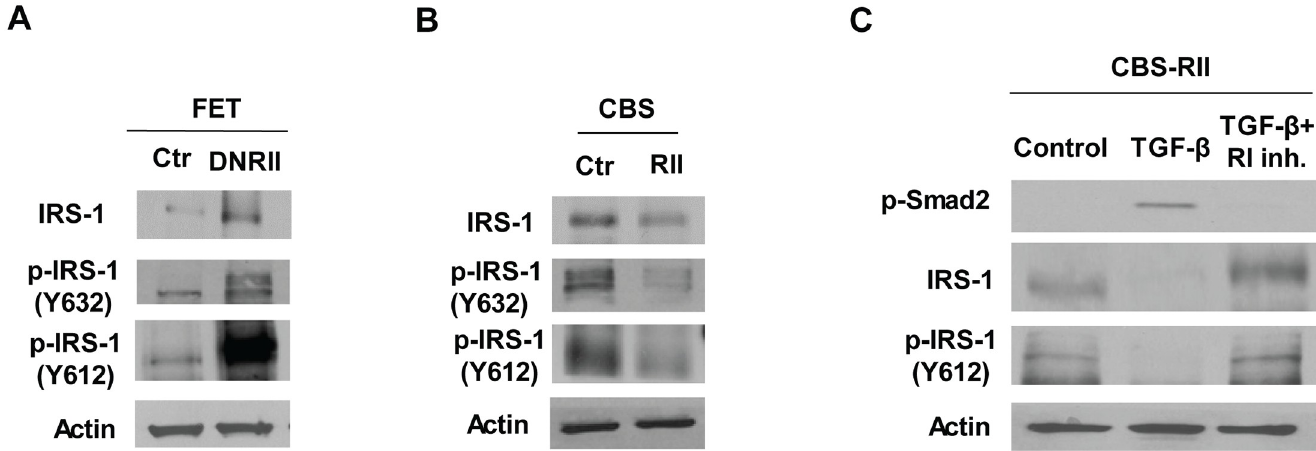
Fig 2. TGF β inhibits expression and phosphorylation of IRS-1 in colon cancer cells. ( A) Expression and phosphorylation of IRS-1 at both Y632 and Y612 were higherin FET-DNRII cells than in control cells, as shown by western blot analysis. (B) Expression and phosphorylation of IRS-1 at both Y632 and Y612 were lower in CBS-RII cells than in the control cells, as shown by western blot analysis. (C) TGF β treatment of CBS-RII cells decreased expressionand phosphorylation of IRS-1, an effect that was prevented by the additionof TGF β RI kinase